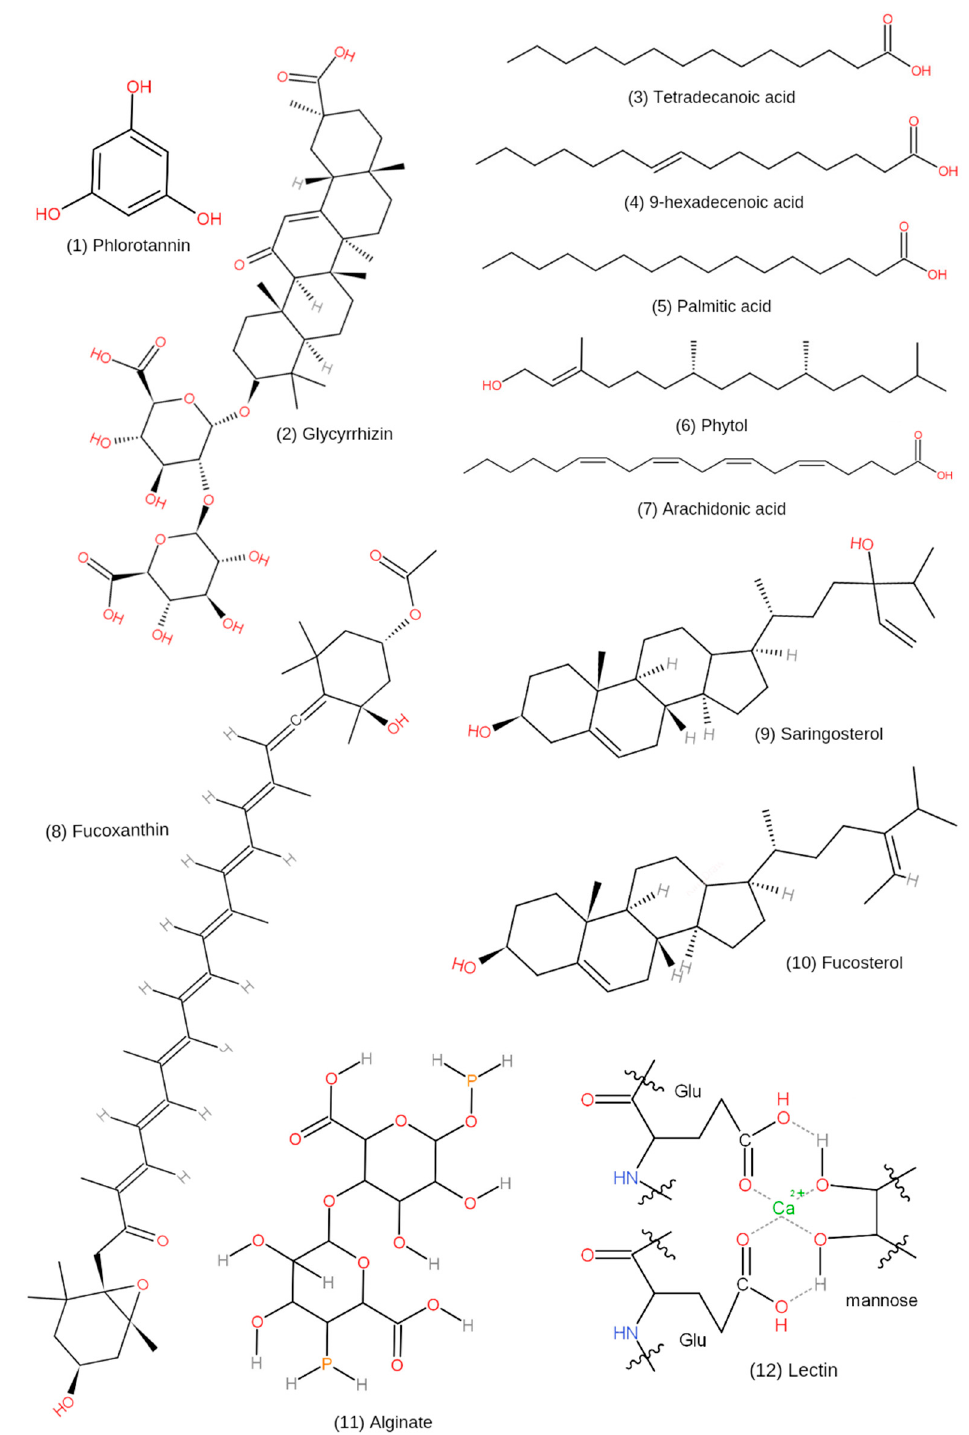
Figure 6. The chemical structures of bioactive compounds in H. fusiformis . ( 1 ) phlorotannins; ( 2 ) glycyrrhizin; ( 3 ) tetradecanoic acid; ( 4 ) palmitic acid; ( 5 ) 9-hexadecenoic acid; ( 6 ) phytol; ( 7 ) arachidonic acid; ( 8 ) fucoxanthin; ( 9 ) saringosterol; ( 10 ) fucosterol; ( 11 ) alginate; ( 12 ) lectin.